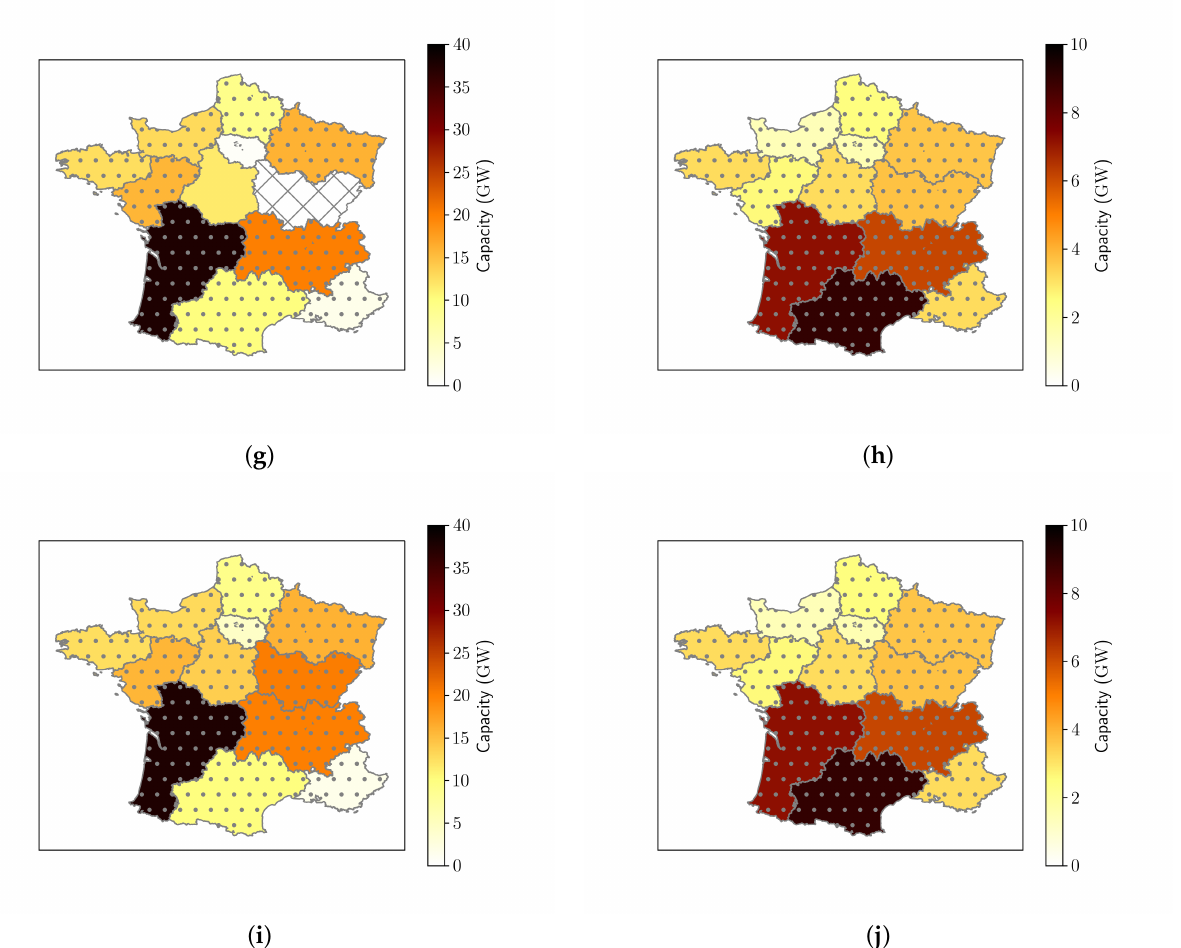
Figure 7. Regional distribution of the optimal wind ( left ) and photovoltaic ( right ) capacities for the variable problem at selected values of the expected system total cost without variable renewable energy. Regions in which no capacity is installed for a given technology are hatched by gray crosses. Regions in which the maximum capacity (Figure 3e,f) is installed are hatched by gray dots. ( a , b ) E ( STC ( 0 )) = 10G A C/y; ( c , d ) E ( STC ( 0 )) = 30G A C/y; ( e , f ) E ( STC ( 0 )) = 50G A C/y; ( g , h ) E ( STC ( 0 )) = 100G A C/y; ( i , j ) E ( STC ( 0 )) = 150G A